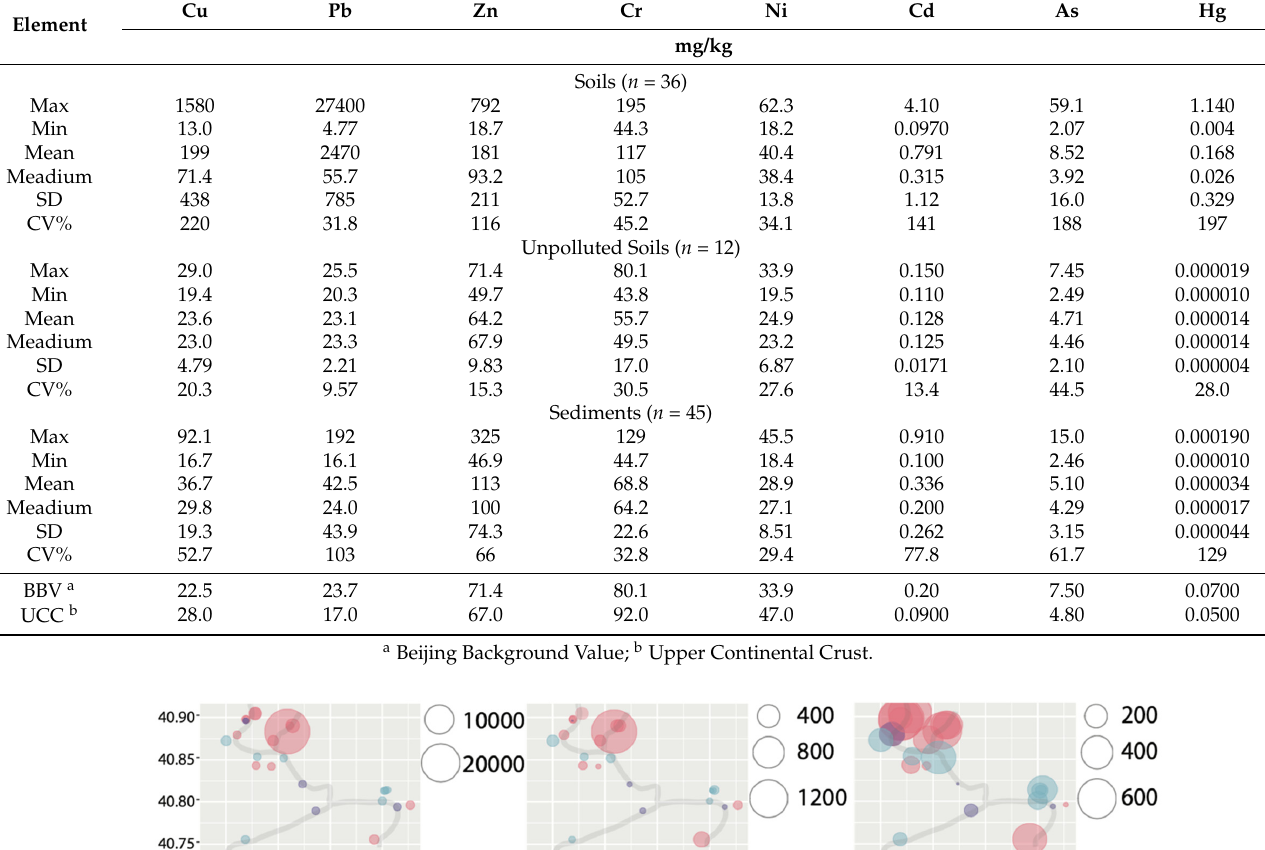
The pollution assessment methods, including CF , PLI , I geo , and RI , generally reflected higher contamination levels in the soils than in the sediments, as shown in Figure 3 and Table 2. For example, average CF values of Cu, Pb, Zn, Cr, Ni, Cd, As, and Hg in sediments were 1.63, 1.79, 1.58, 0.86, 0.85,1.68, 0.68, and 0.49, respectively, which belong to the unpolluted ( CF < 1) and moderate-to-low (1 ≤ CF < 3) polluted levels (Table 2). However, the average CF values of PTEs in soils were much higher with very high polluted levels ( CF ≥ 6) of Cu (8.84) and Pb (8.80); high polluted levels of Cd (3.96); and moderate-to-low polluted levels of Zn (2.53), Cr (1.46), Ni (1.19), As (1.14), and Hg (2.40). The PLI values of the sediment sites ranged from 0.57 to 1.92 with an average of 0.97, indicating almost no heavy pollution ( PLI > 1), while seven of the 12 soil sampling sites had PLI values within 1.2-9.8 (Table 2). Similarly, the mean I geo value for each PTE in the sediments was below zero, while the mean I geo values in soils for PTEs ranged from − 1.37 to 1.56 (Figure 2). The difference in I geo between soils impacted by mining activities (SI1-SI12) and unpolluted soils (SO1-SO4) can be clearly seen in Figure 2, with I geo values as high as 9 for the former and below 0 for the latter. Notably, for Pb, the Igeo values for SI1, SI5, and SI6 were classified as strongly contaminated (4 ≤ I geo < 5), and for SI6, it was classified as extremely contaminated ( I geo ≥ 5). Notably, the highest PLI value was found at SI6 (9.8), followed by SI11 (4.4), SI1 (2.5), and SI5 (2.1), all located within 2 km of either of the tailings ponds, mines, or the smelters (Figure 1); thus, proximity to mining activities might account for the higher PLI at these soil sites. None of the PTEs in sediments showed a heavy or extreme pollution index with I geo < 3. Sediment sampling sites did not have high or very high contamination indices, and most sampling sites were uncontaminated to moderately contaminated with PLI < 2, CD < 20, and RI < 300 (Table 2). One-third of the sediment